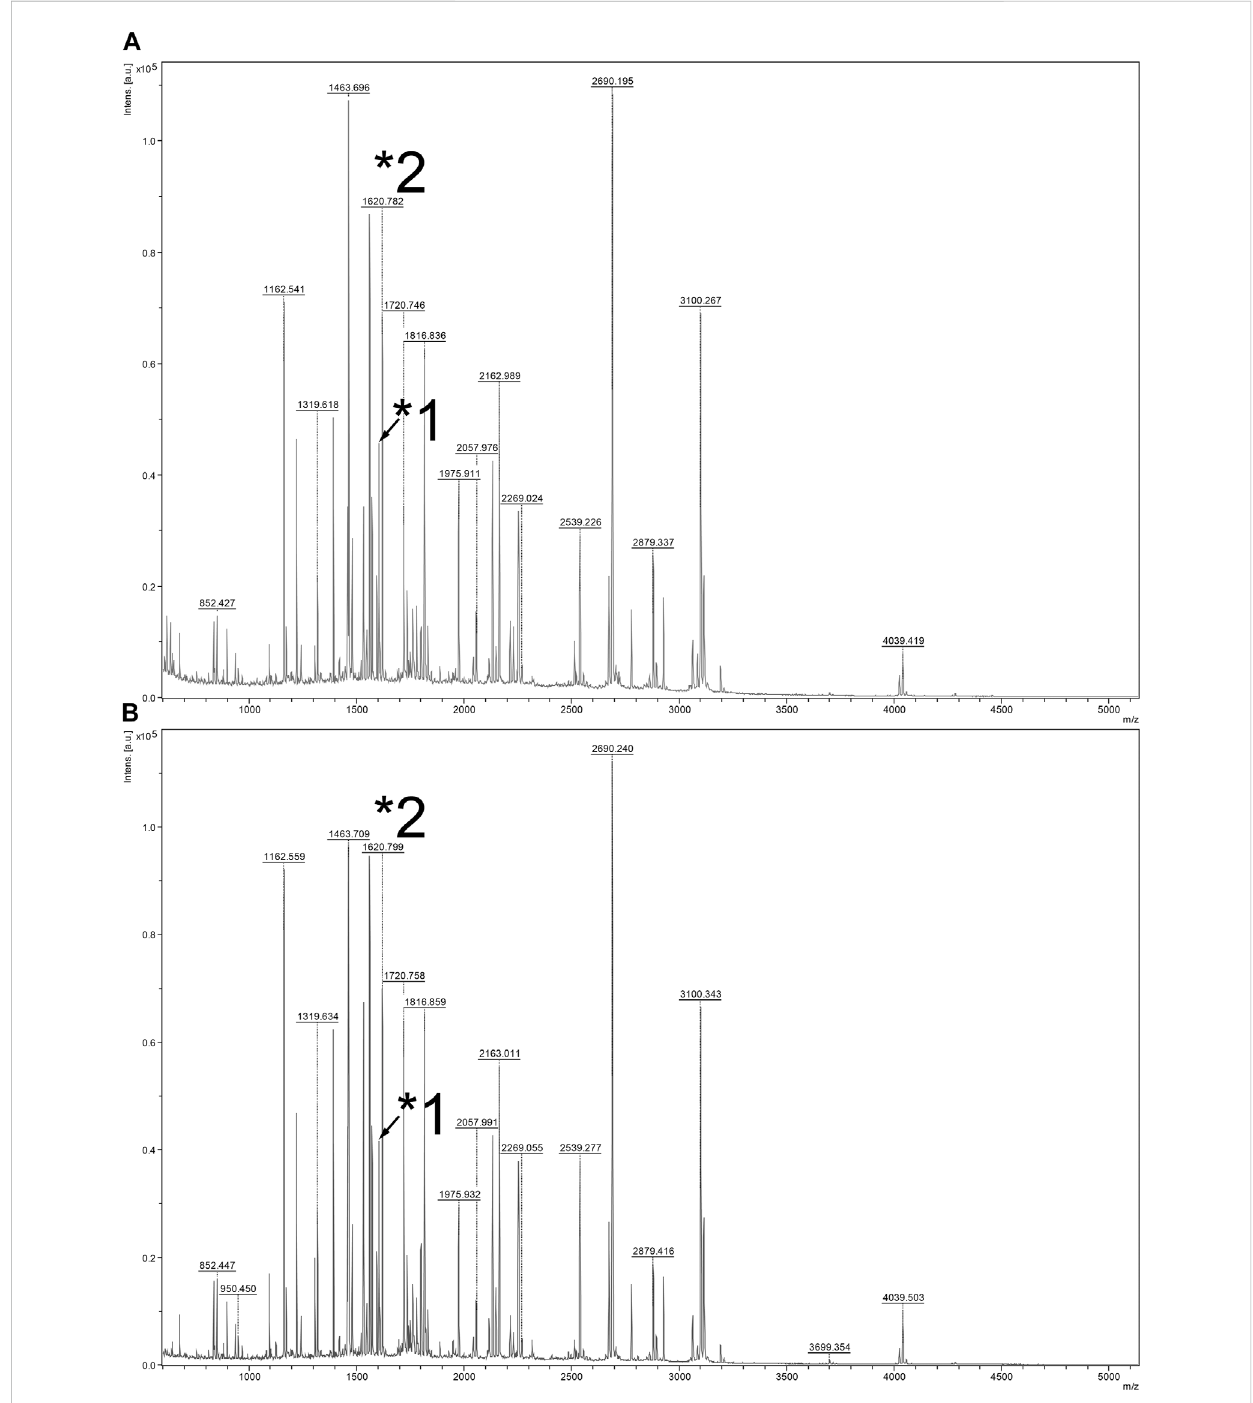
FIGURE 3 Time-of- fl ightmassspectrometrypro fi le oftwosamplesfromtheKarako-Kagisite[ (A) :leftfemurand (B) rightpelvis].Notethatbothsampleswere identi fi ed as chicken due to the presence of two peaks (*1 and